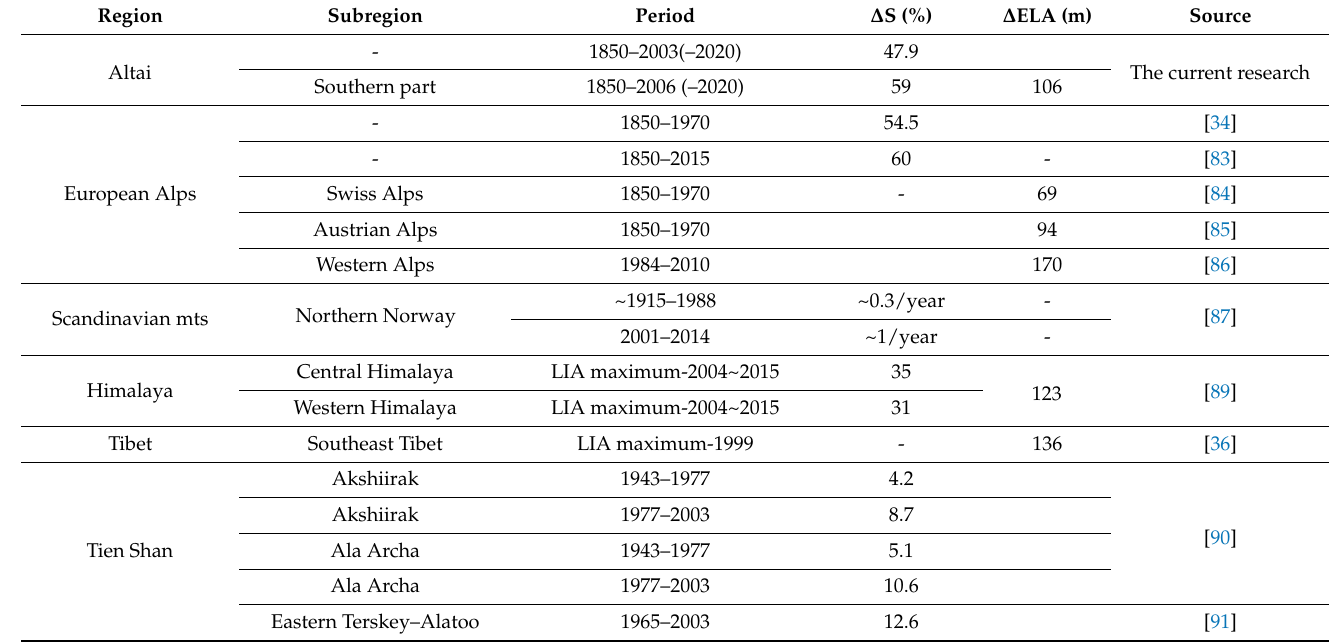
Table 8. Regional comparison of glacier